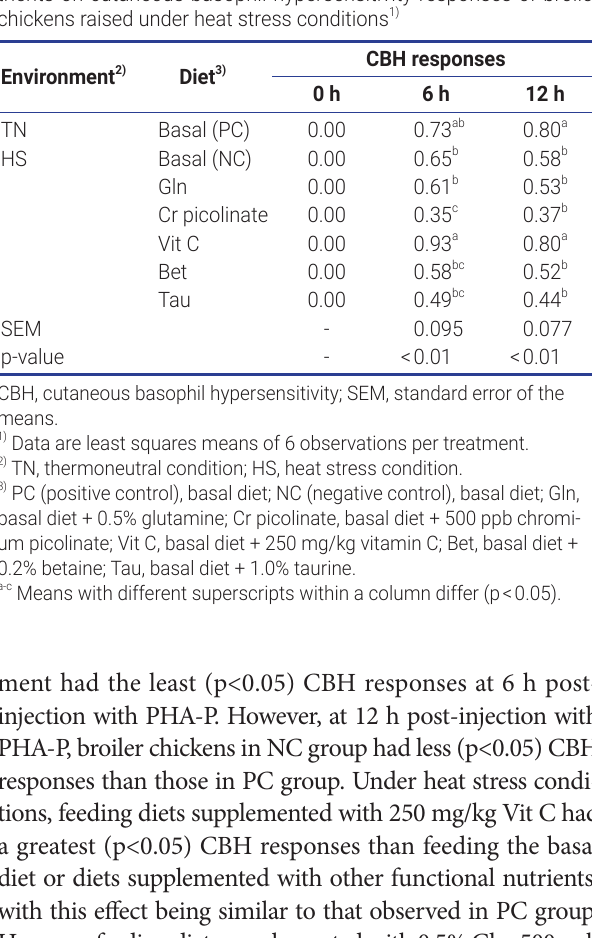
Table 5. Effects of dietary supplementation of various functional nu- trients on stress biomarkers of broiler chickens raised under